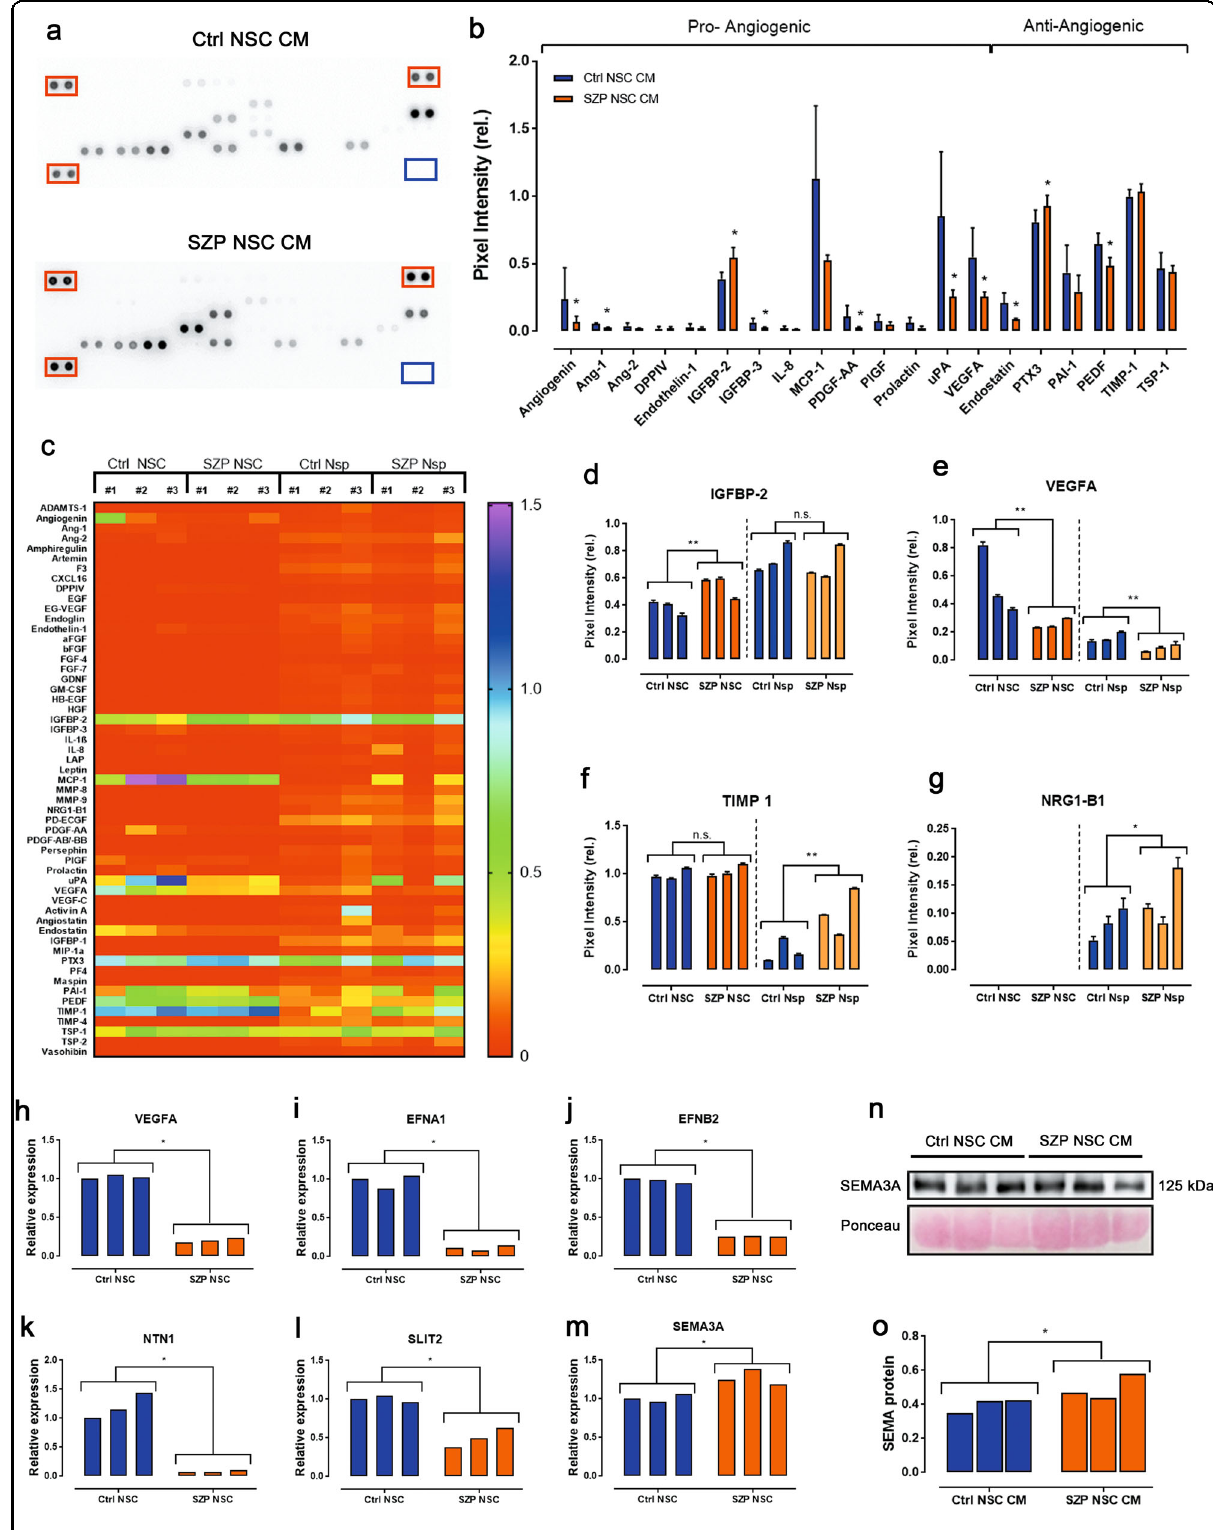
Fig. 2 (See legend on next